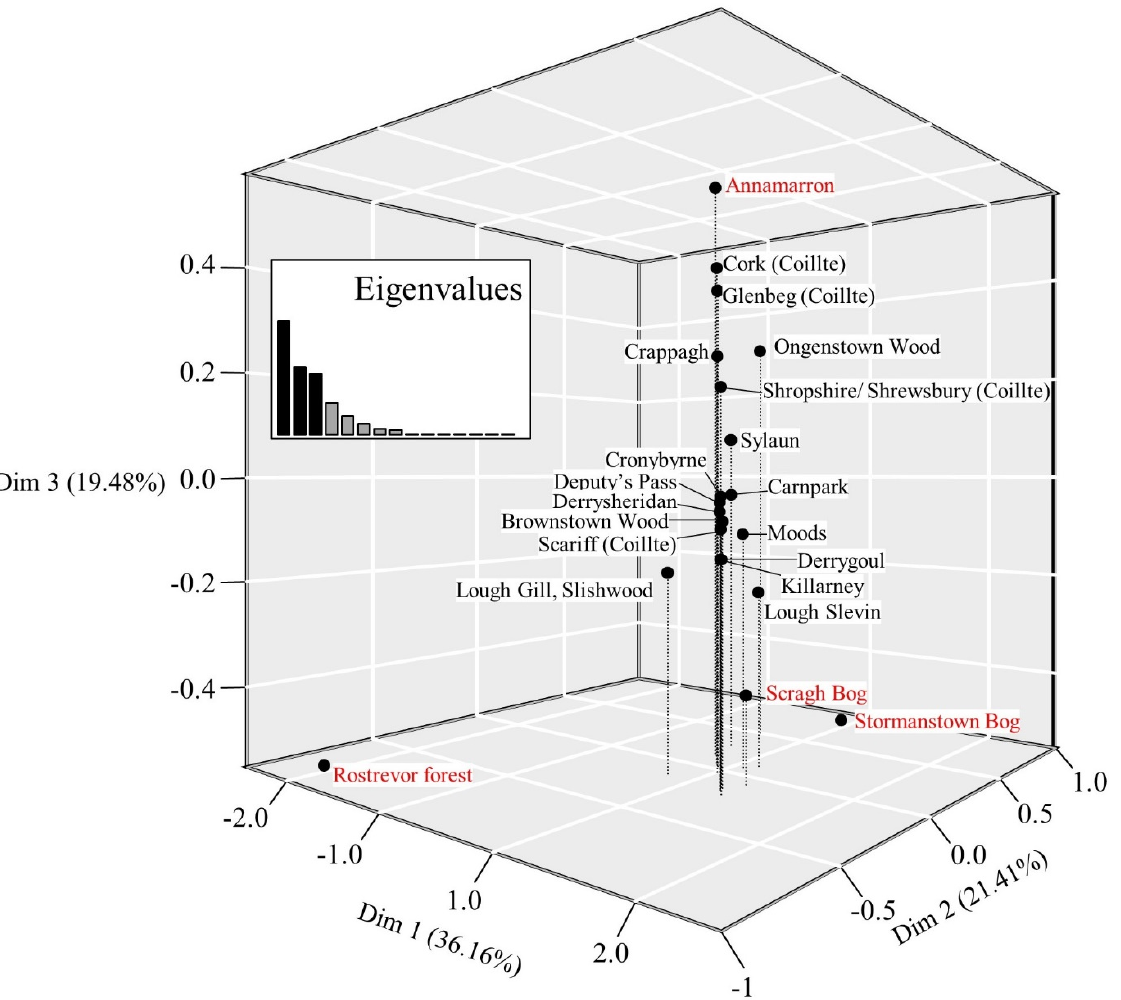
Figure 5. Results of an FCA performed on an allele contingency table at the population level. Plotted are the first three eigenvalues (subset, black), which account for 77.05% of the allelic variation between sample populations. Highlighted in red are populations which are indicated to be particularly differentiated relative to each other and to the other populations.